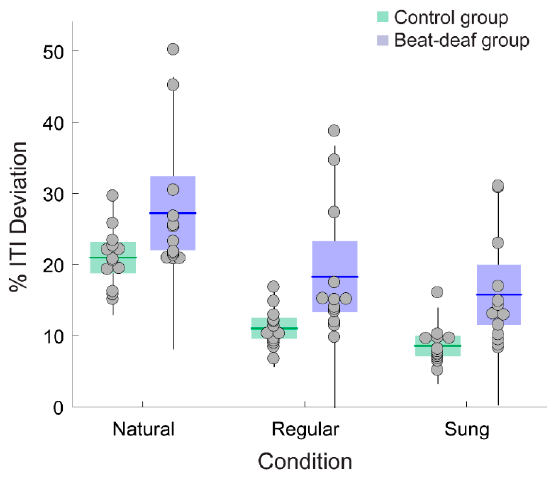
Figure 3. (a) Coefficient of variation (CV) of the intervocalic interval (IVI) between stressed syllables of the stimuli. Each dot represents a sentence. (b) Mean CV of the inter-tap interval (ITI) produced by the beat-deaf and control group as a function of sentence type. Each dot represents a participant. Boxes correspond to a 95% confidence interval from the mean based on the standard error of the mean (SEM). The darker horizontal line within each box indicates the group mean, while the vertical lines represent two standard deviations from the mean.